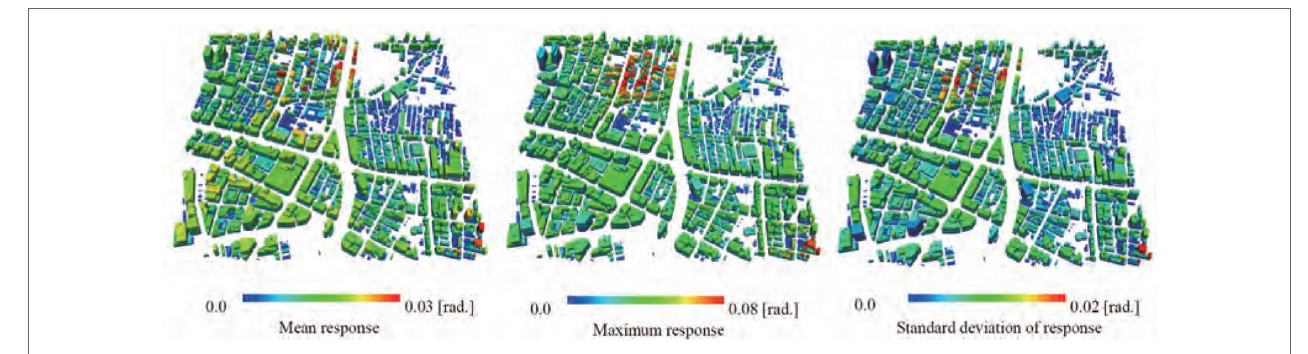
FigUre 12 | Distribution of mean, maximum and SD of